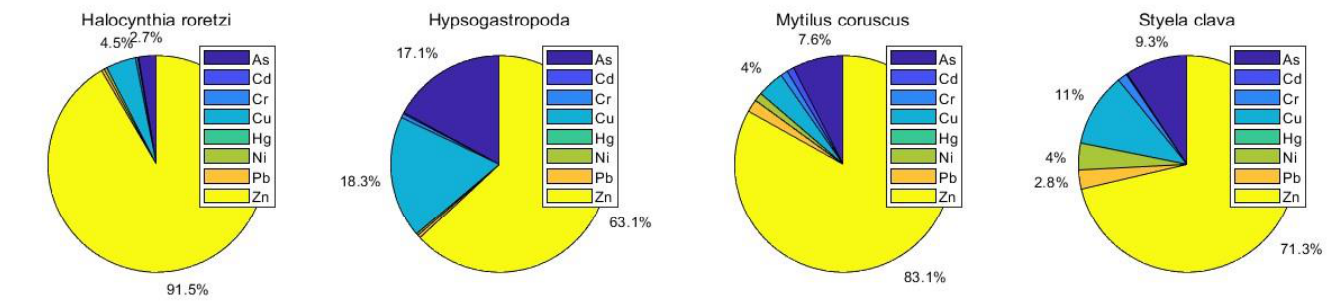
Figure 4. Composition of eight heavy metals of Halocynthia roretzi , Hypsogastropoda , Mytilus coruscus , and Styela clava .